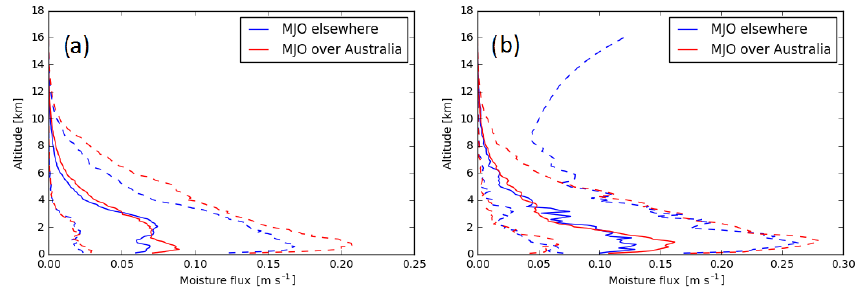
(cid:18)(cid:16) (cid:19) (cid:17) 1 / 2 u 2 + v 2 q , where q is specific humidity during break conditions. (b) as in (a) ,